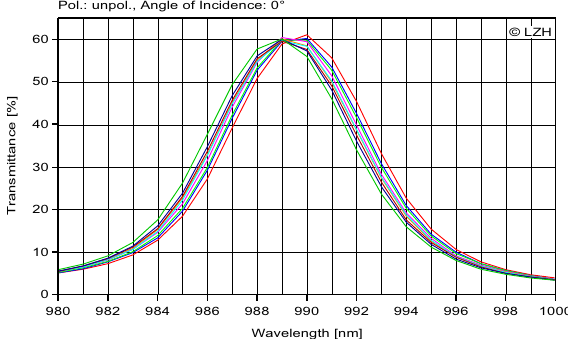
Fig. 2. Filter centered at 990nm. All curves are from measurements taken on positions from center to the edge representing a distance of 40mm.